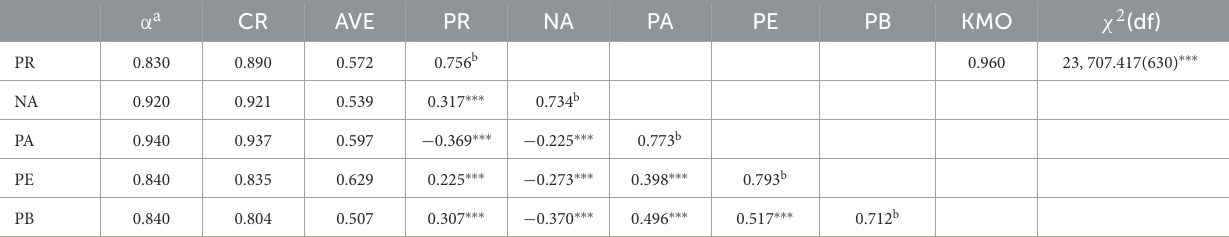
TABLE 2 Descriptive analysis and correlation analysis.